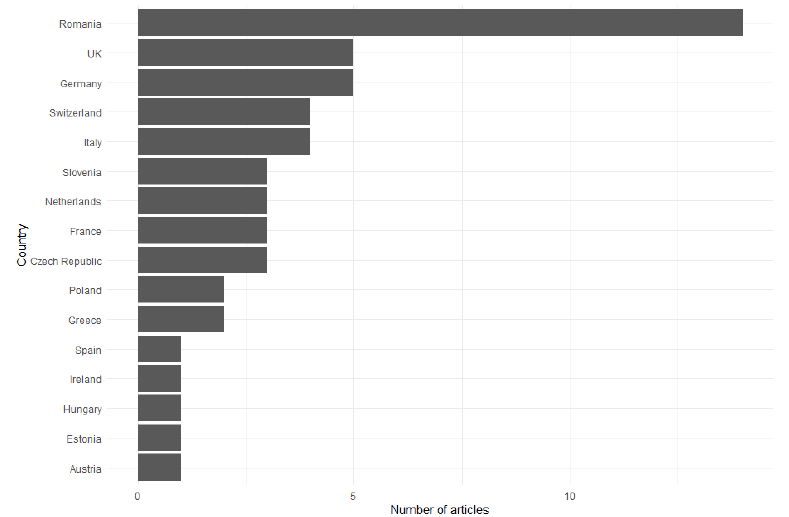
Figure A3. Number of included articles and the country in which they were conducted. Note that whilst 52 articles were included, the total here sums to 53 since one study was conducted in both France and Switzerland and is included in the count of both countries here.